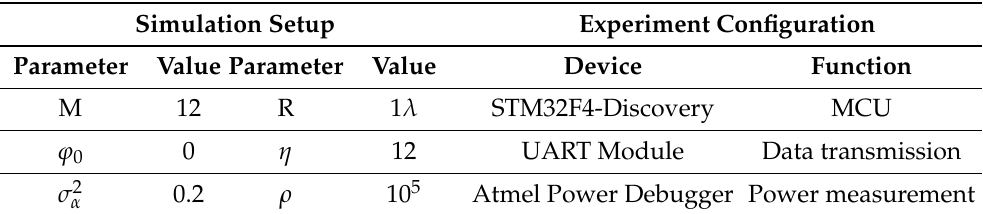
Table 2. Summary of simulation setup and experiment